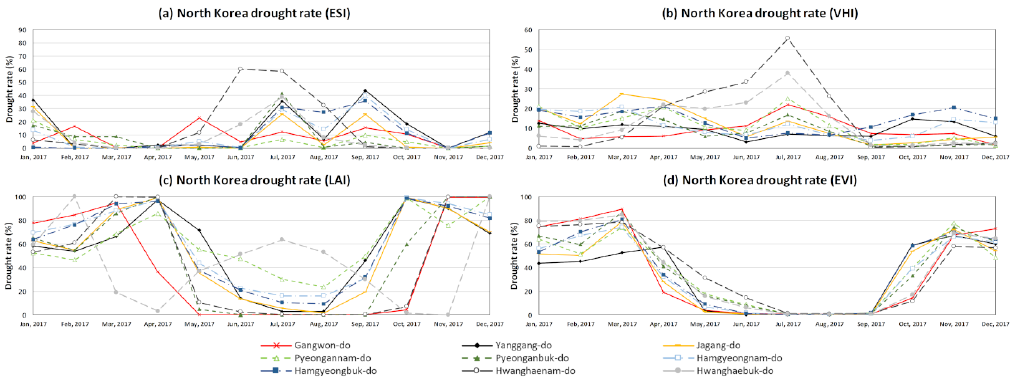
Figure 5. Temporal changes in drought area ratios of total area in each district as determined by the ( a ) ESI, ( b ) VHI, ( c ) LAI, and ( d ) EVI values for the nine provinces in North Korea during the 2017 drought event.